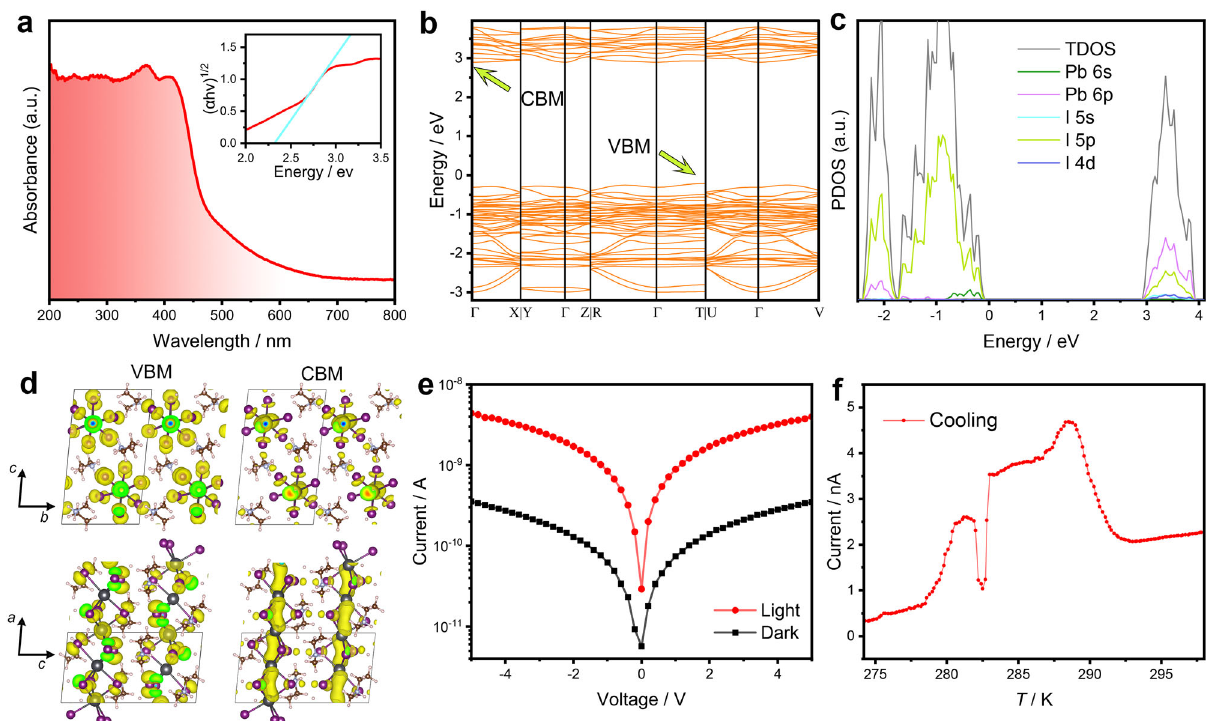
white light with the intensity of 130mWcm − 2 . f I − T curve corresponding to the ITP- HTPtransitionmeasuredat10Vuponawhitelightwiththeintensityof80mWcm − 2 . Source data are provided as a Source Data fi